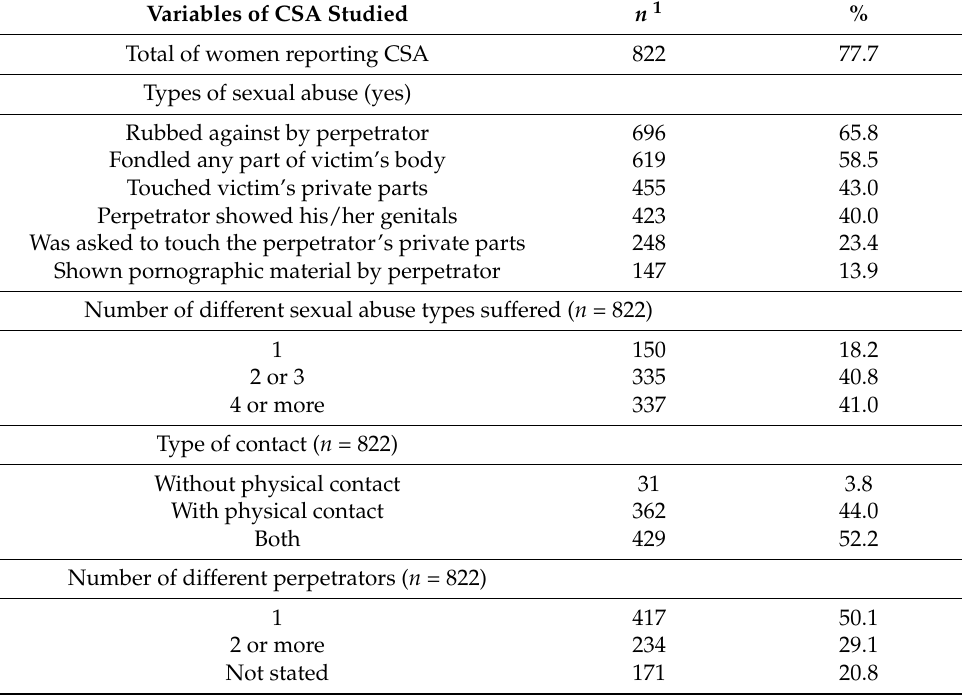
Table 1. Number of participants and percentages for the variables of sexual abuse